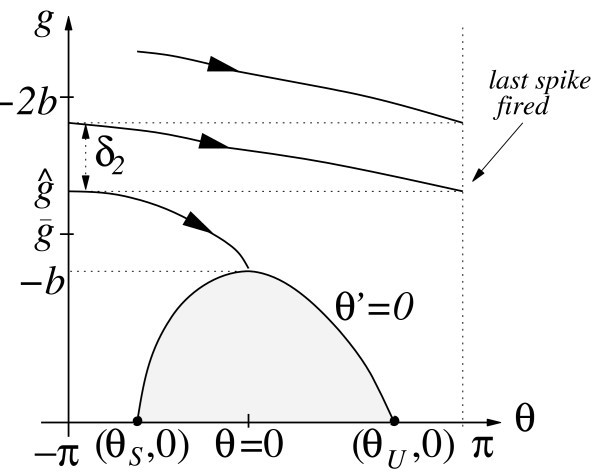
Schematic illustration of the (θ, g) phase plane including our approximation to  and . The shaded region indicates the set where θ' < 0. δ2 is the change in g as θ evolves from -π to π for the firing of the neuron's final spike.